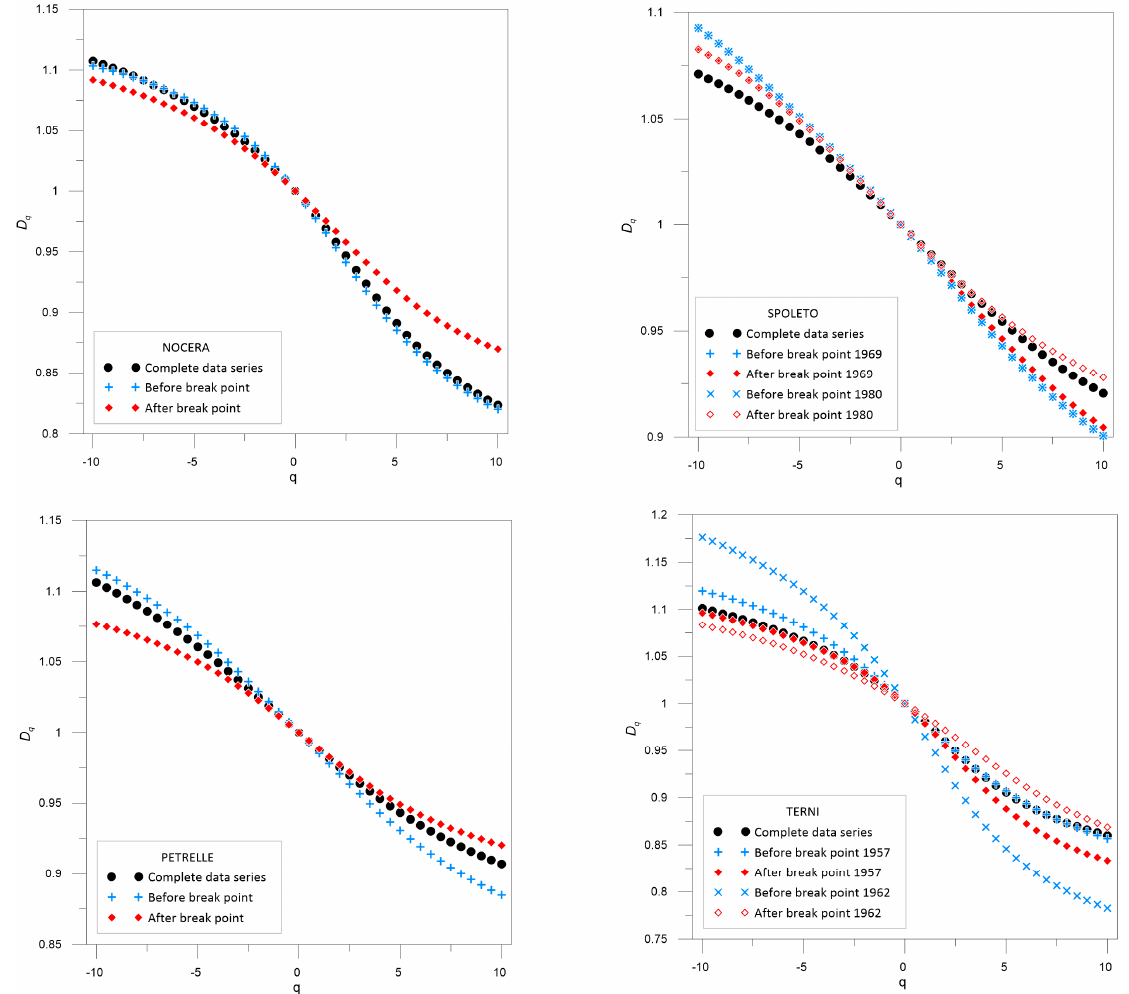
Figure 5. Multifractal dimensions functions D q for the complete data series and also for the rainfall series before and after the break points detected in the Nocera Umbra, Petrelle, Spoleto and Terni stations.